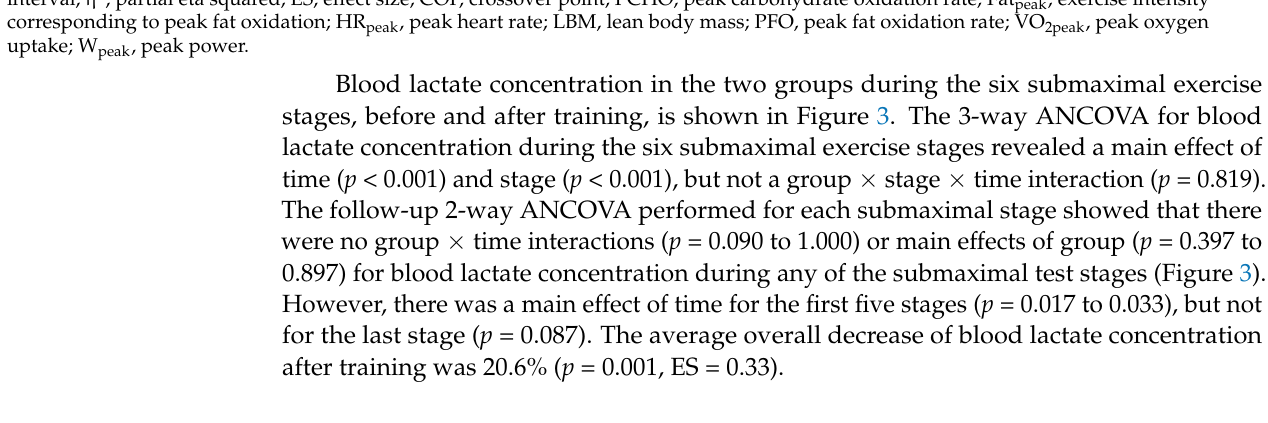
Values are expressed as means ± standard deviation. Bold font highlights statistically significant differences. 90% CI, 90% confidence interval; η 2 , partial eta squared; ES, effect size; COP, crossover point; PCHO, peak carbohydrate oxidation rate; Fat peak , exercise intensity corresponding to peak fat oxidation; HR peak , peak heart rate; LBM, lean body mass; PFO, peak fat oxidation rate; VO 2peak , peak oxygen uptake; W peak , peak power.